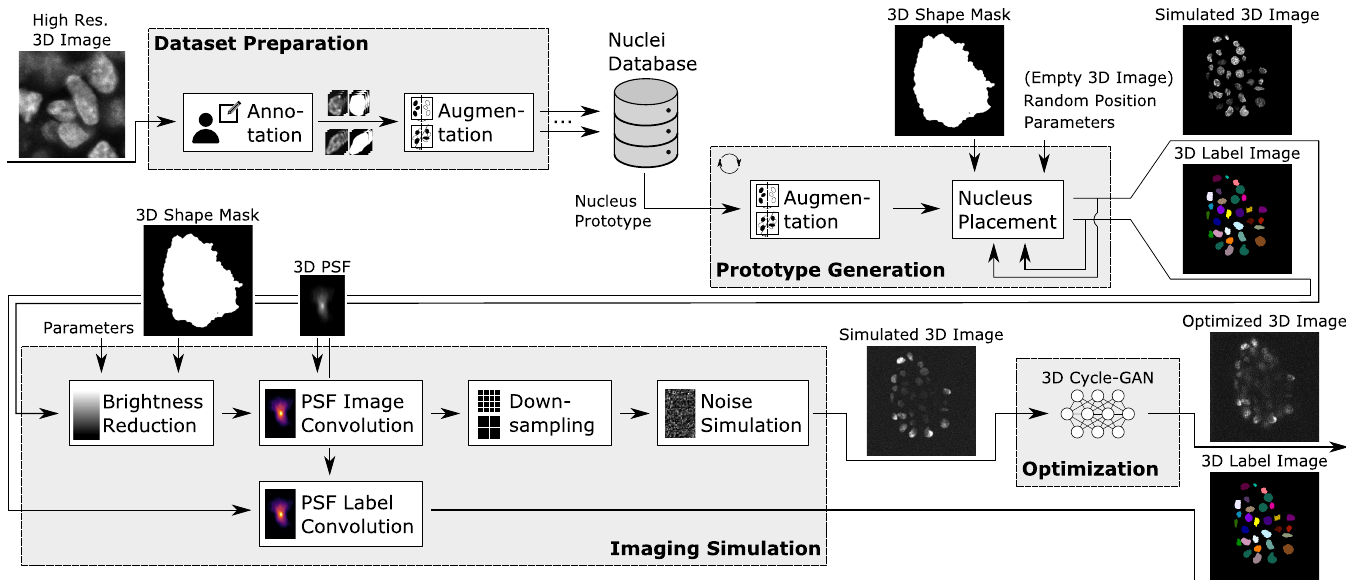
Fig 2. Concept of the data synthesis pipeline. The pipeline consists of four steps: dataset preparation, prototype generation, imaging simulation, and optimization. In favor of a clear visualization, 3D images are shown as 2D slices.